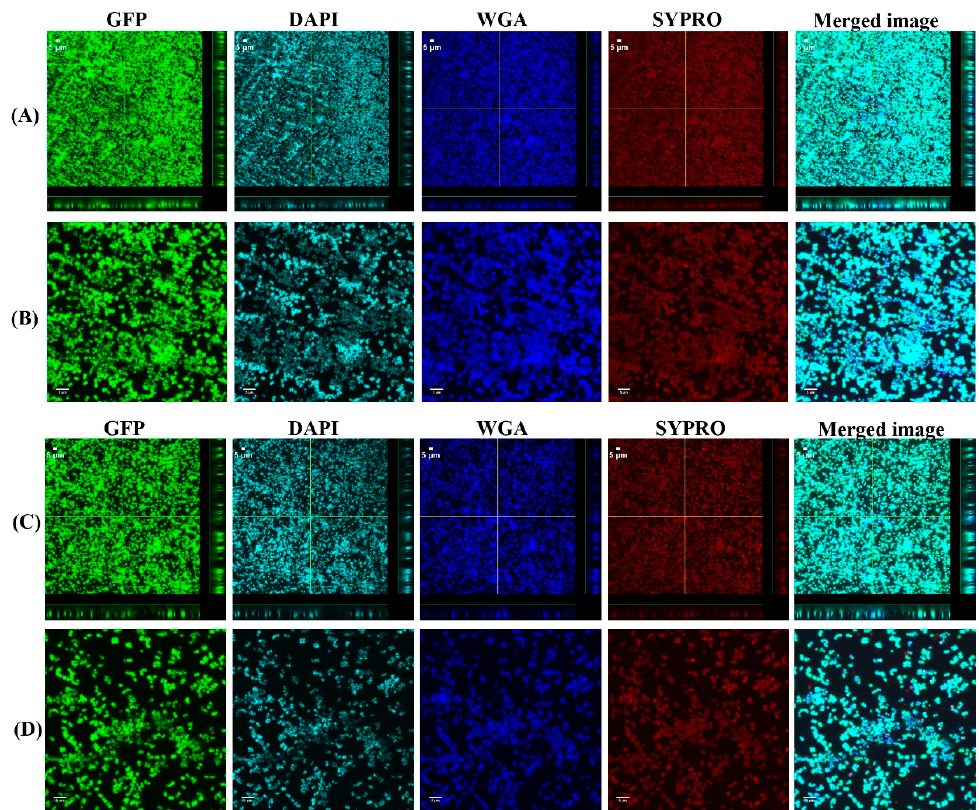
Figure 2. Confocal images of aggregated ( A , B ) and single cells ( C , D ) biofilms for 10 8 CFU/mL. Panel B and D are zoomed images. Biofilms stained with DAPI for eDNA, WGA stain for PNAG or SF-derived HA, and SYPRO for staining proteins contained in the biofilm matrix. Merged images denote the combination of GFP, DAPI, WGA, and SYPRO